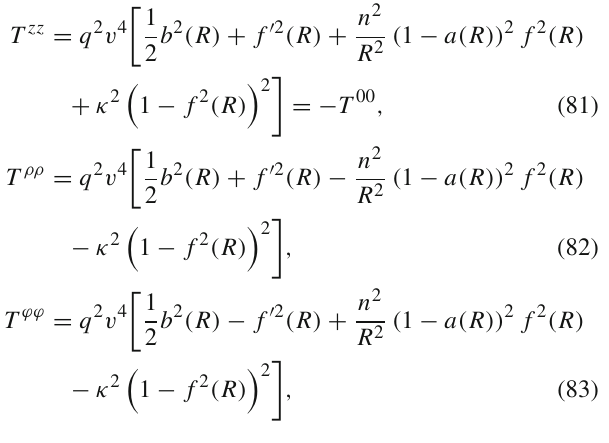
and all the off-diagonal components vanish.